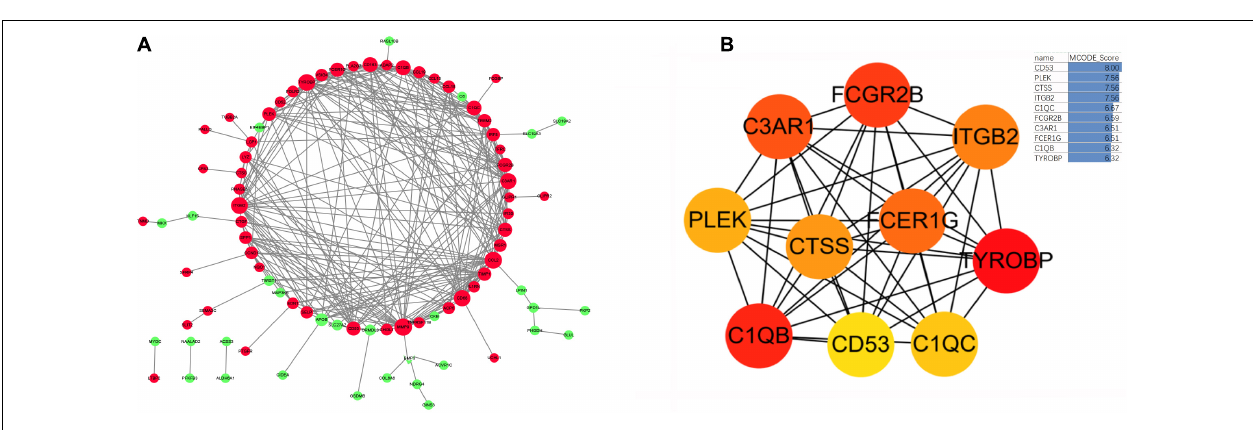
FIGURE 6 | (A) The protein-protein interaction network diagram of DEGs in obese adipose tissue, red and green indicate that the node is upregulated and downregulated, respectively. The area of the node indicates the degree to which the node is connected to other nodes. (B) The top 10 hub genes screened by the MCC method in Cytohubba. The deeper yellow is the hub gene with a higher score, MCODE Score is calculated by MCC method, higher score means higher degree of